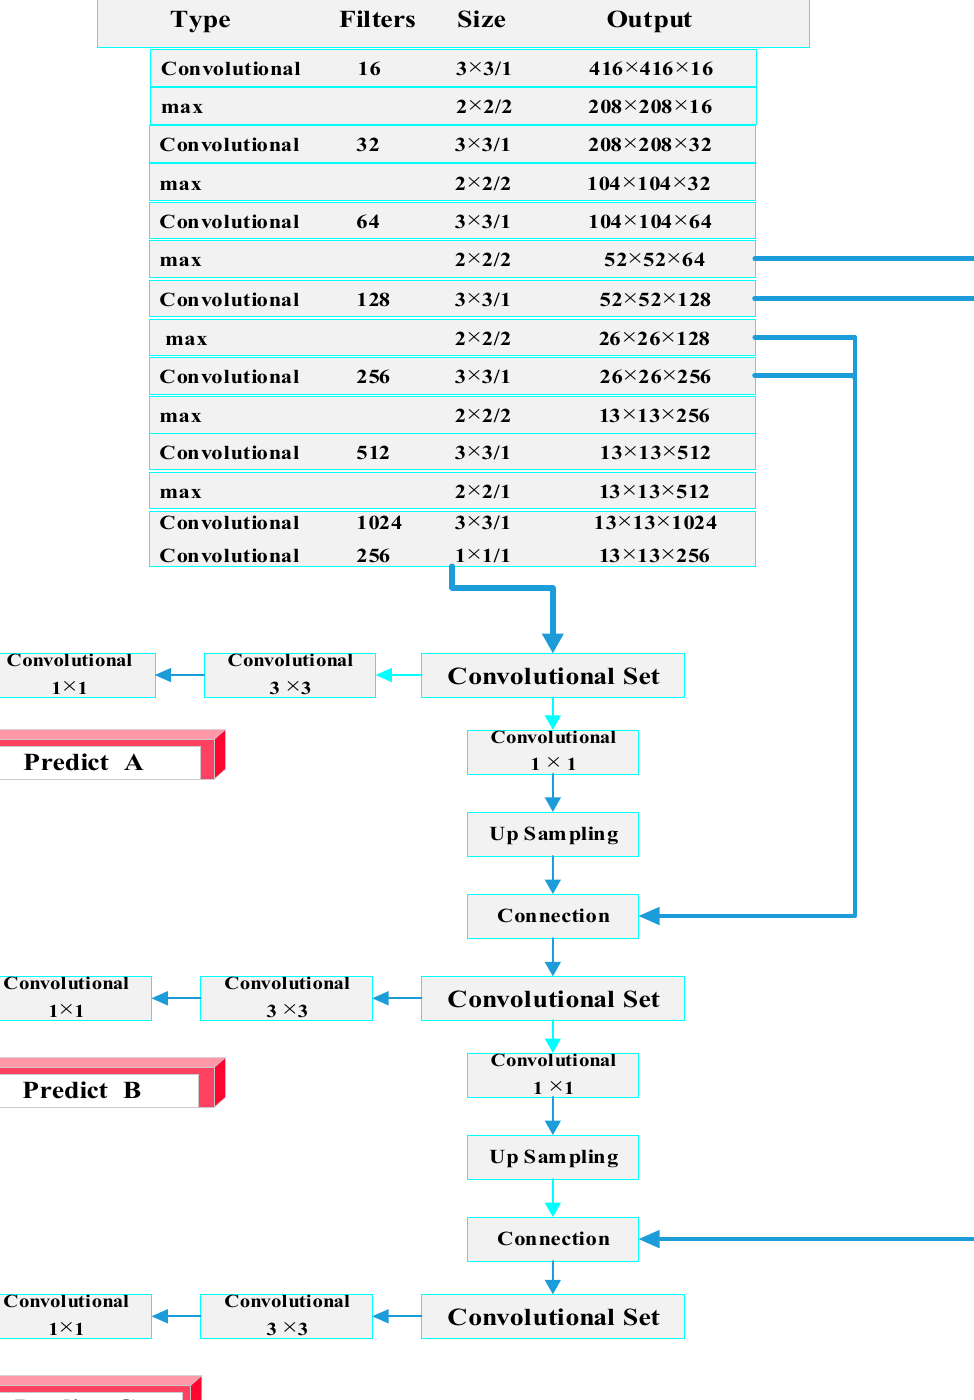
Figure 2. The designed concept of the proposed tiny fast You Only Look Once (TF-YOLO) network. Multi-scale detection is more sensitive to small targets. Multi-scale fusion makes full use of features of the input image. k-means++ is applied to find more excellent priori boxes of the targets.